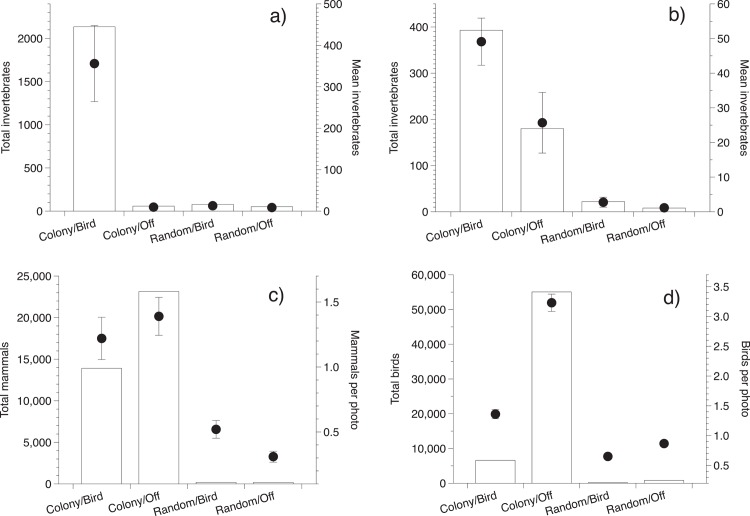
Faunal abundance under Aplonis metallica (metallic starling) colony and random trees during the bird nesting and off seasons.(a) Invertebrates in sticky-trap samples and (b) soil; camera-trap counts of (c) mammals and (d) birds as a function of location (colony trees vs. random trees) and season (bird nesting season vs. off-season). Figures for each taxon show total number of individuals recorded (columns) and mean (±SE) values (points) of animals per survey.